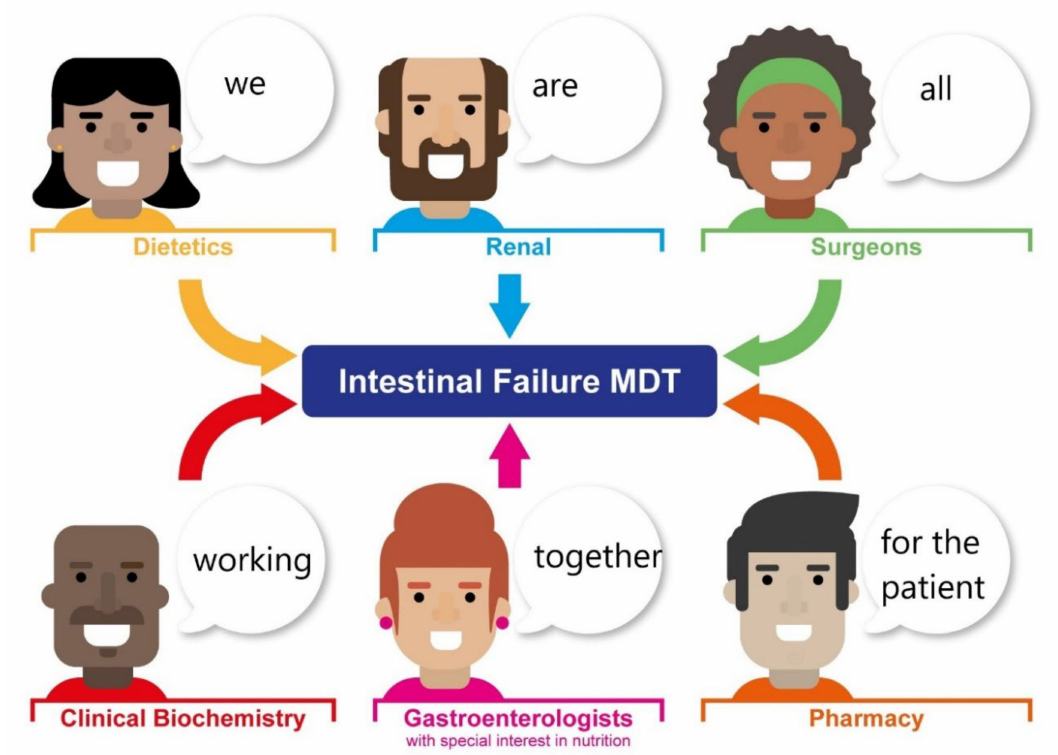
Figure 3. Graphical representation of multidisciplinary team meeting (MDT) managing complex patients with intestinal failure. Every member of the team plays an important role to reach the common outcome of improving patient